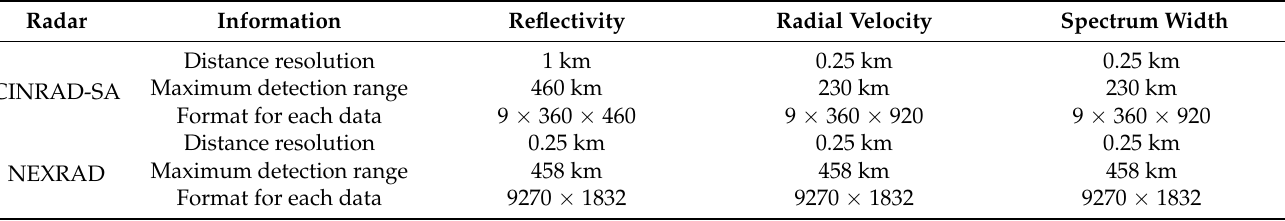
Table 1. The level-II data information for CINRAD and NEXRAD. The reflectivity, radial velocity, and spectrum width are three meteorological fundamentals for weather radars. The polarization data are not